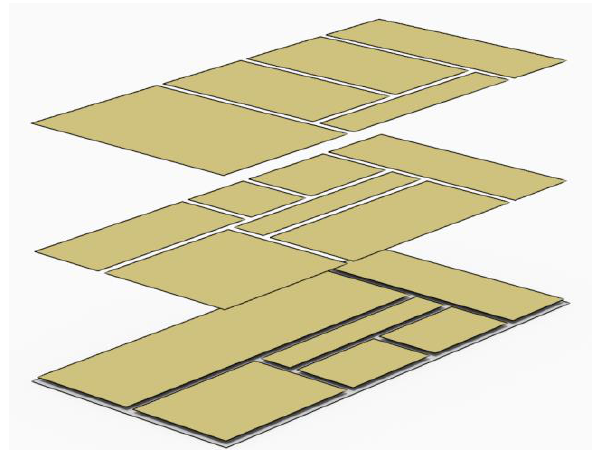
Figure 2. LoD0 representation of the exterior and the interior (rooms) of buildings.